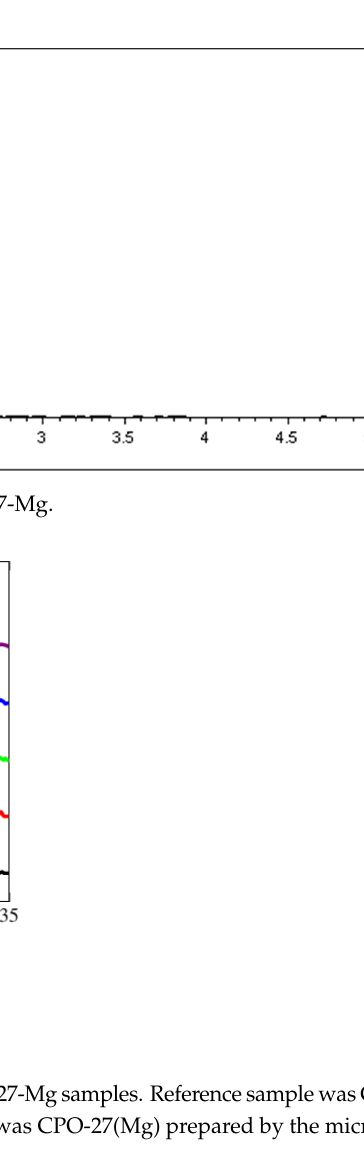
Figure 3. SEM image of crystallized CPO-27-Mg.